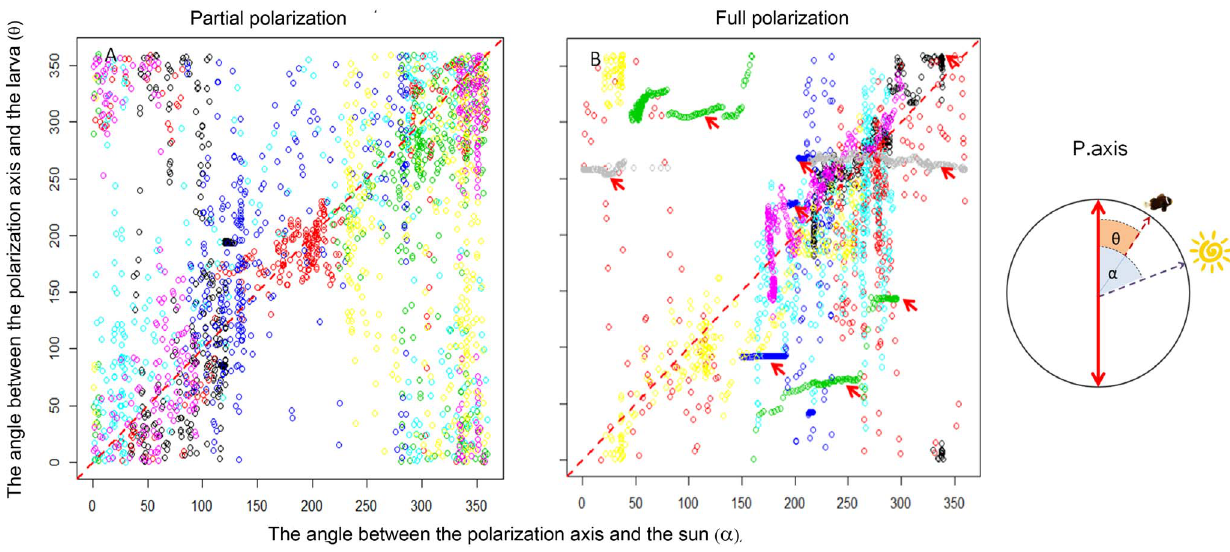
Figure 6. Premnasbiaculeatus follow the rotating filter in the full polarization treatment. Larval position, measured at 2 s intervals, relative to the axis of polarization ( h ; Y-axis); as the axis changes its direction relative to the sun ( a ; X-axis). Different colors represent different larvae, under partial and full polarization (panels A & B). Points along the equality line (dashed line) depict larvae swimming towards the sun. Horizontal sequences of points (marked by red arrows) depict larvae that track the polarization axis, as it rotates along with the DISC.